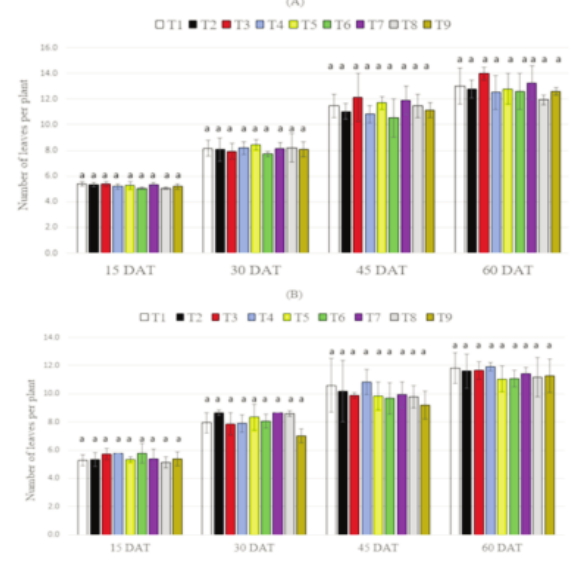
Fig. 3 ­ Number of leaves per plant for tomato cv. Roma under different treatment against Tuta absoluta in trials one (A) and two (B). T1: Steinernema sp. RW14­M­C2a­3, T2: Steinernema sp. RW14­M­C2b­1, T3: Metatech®WP ( Metarhizium anisopliae , Strain FCM Ar 23B3), T4: Beauvitech® WP ( Beauveria bassiana , Strain J25), T5: Tephrosia vogelii , T6: Phytolacca dodecandra , T7: